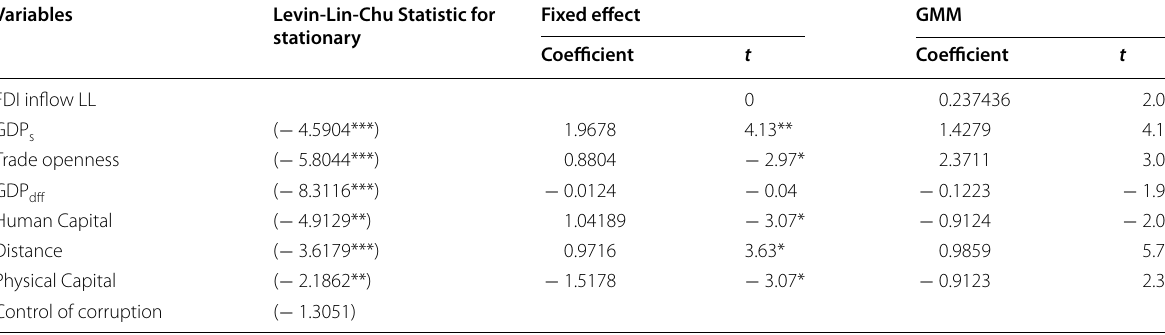
Table 4 Testing for stationarity and generalized method of moments results Variables